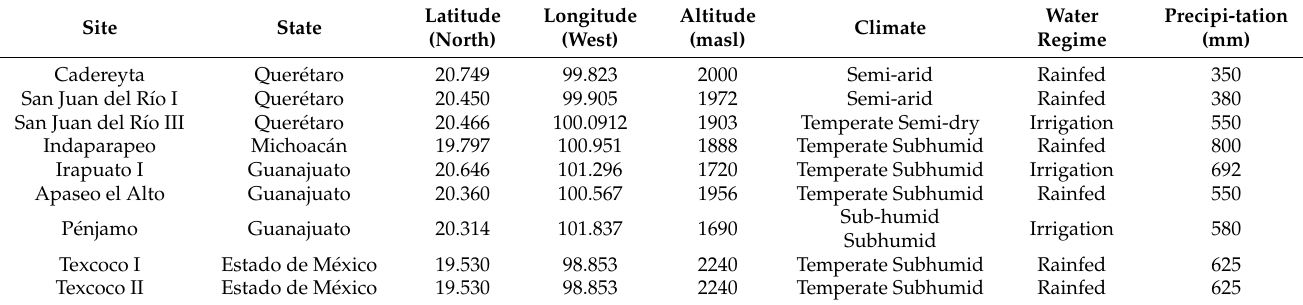
Table 1. Agroecological characteristics of the sites where the study was carried out.